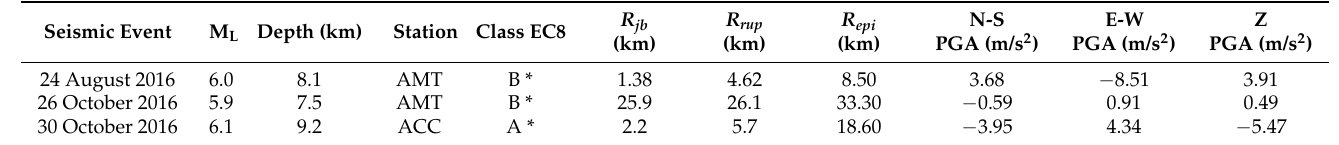
Table 2. The main characteristics of the three quakes considered